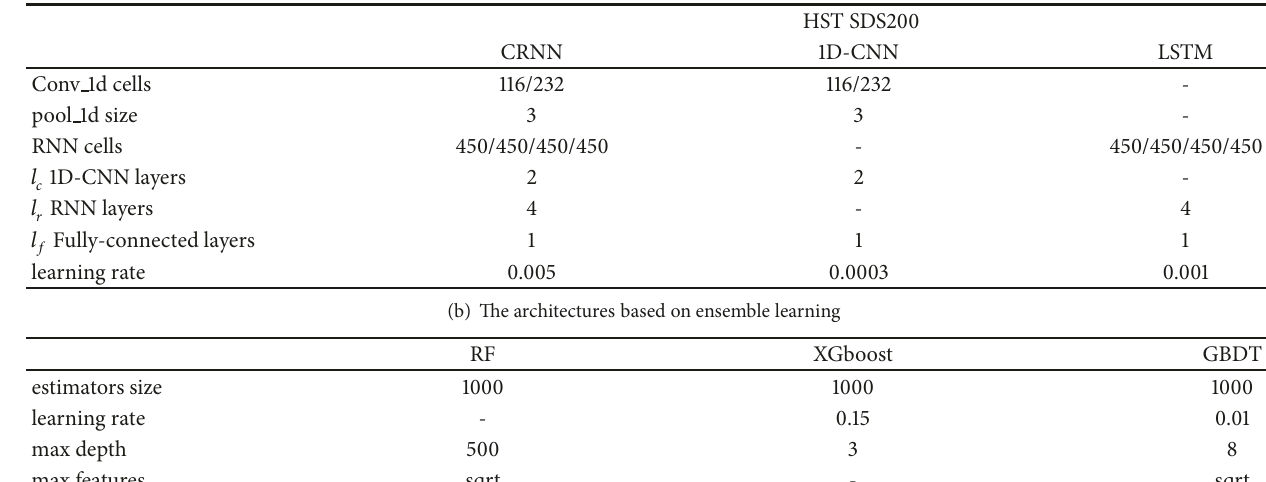
Table 4: Hyperparameters used for comparison experiments.